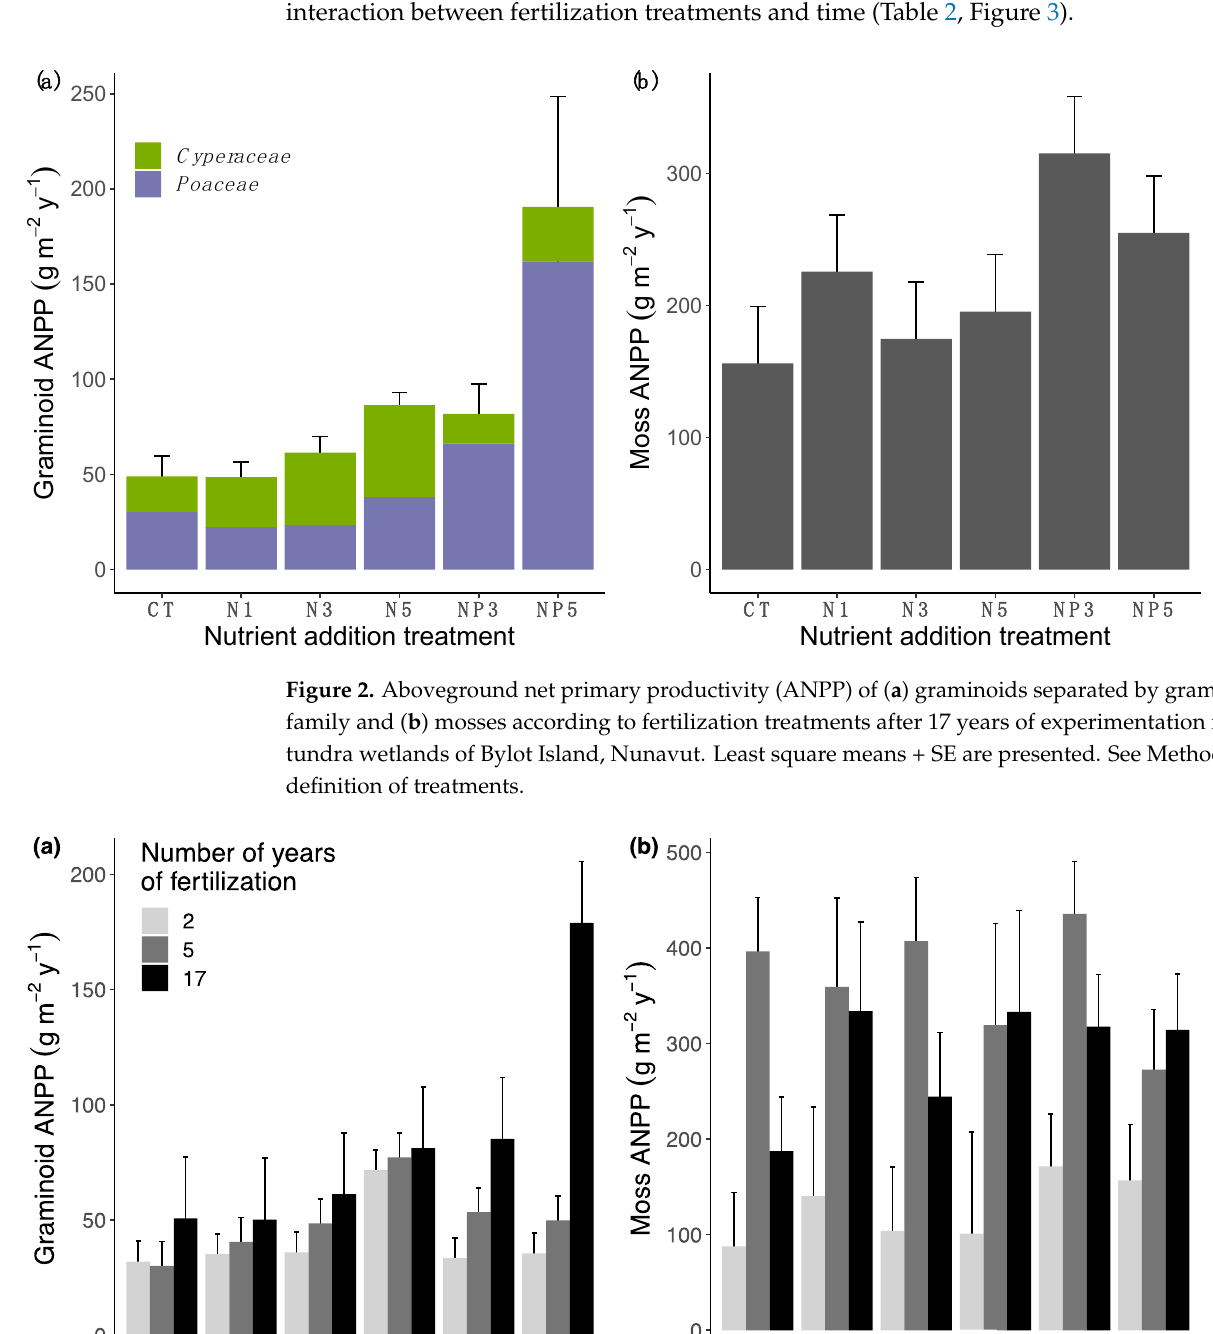
Figure 3. Aboveground net primary productivity (ANPP) of ( a ) graminoids and ( b ) mosses after 2, 5, and 17 years of experimentation according to fertilization treatments in the tundra wetlands of Bylot Island, Nunavut. Least square means + SE are presented. See Methods for definition of